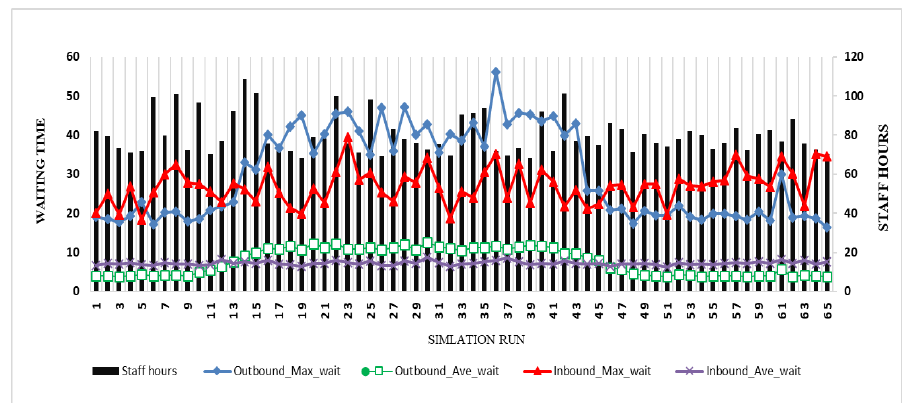
Figure 11. Security screening facility results for shared staffing policies.